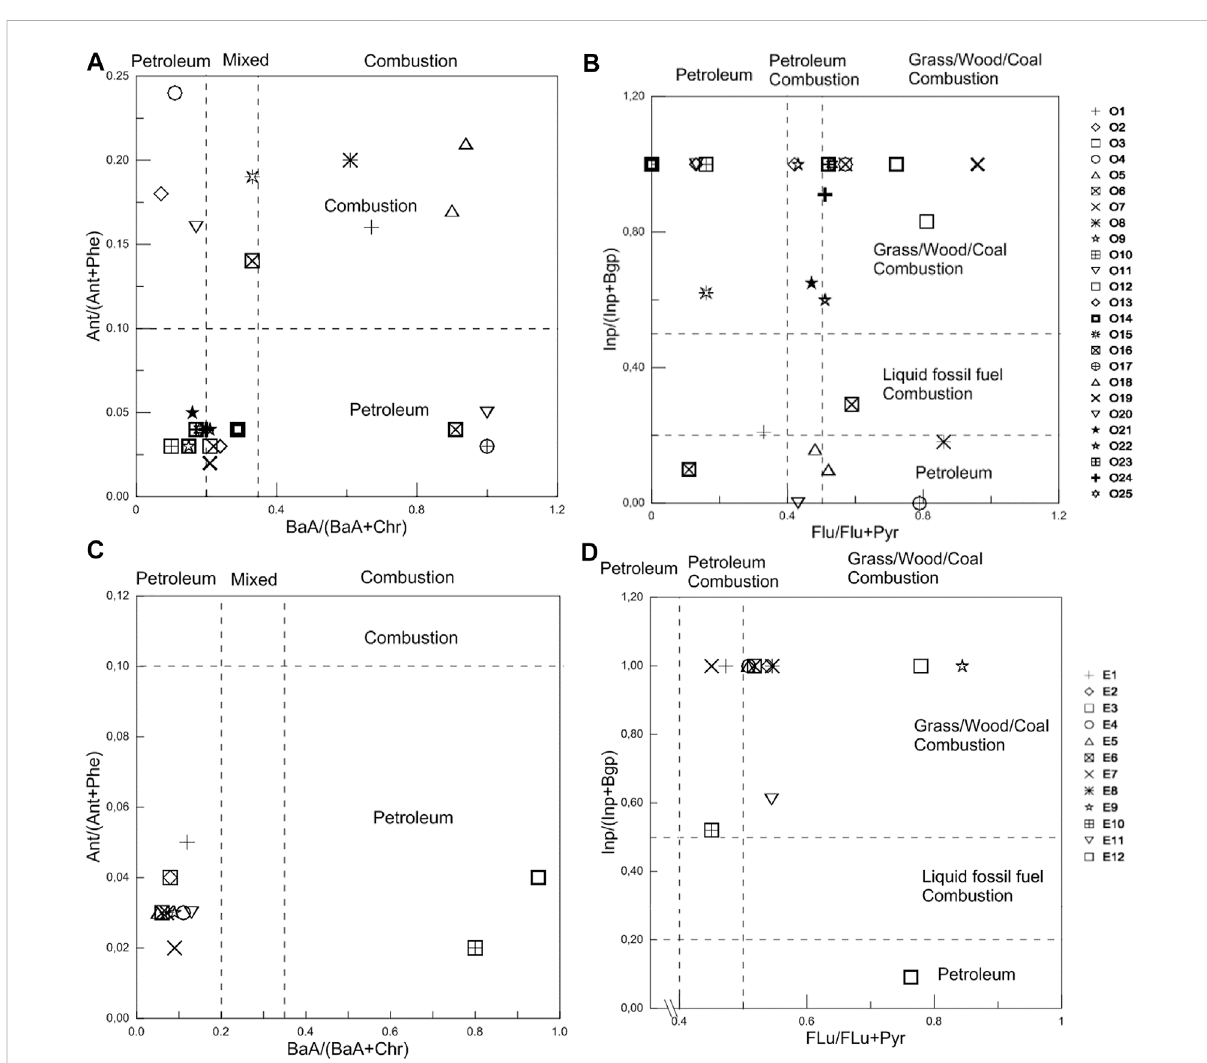
FIGURE 5 PlotsofPAH isomer pair ratiosfor source identi fi cation: (A) Ant/(Ant + Phy) versus BaA/(BaA +Chr) inOilsoil samples, (B) Inp/(Inp + BgP) versus Flu/(Flu+Pyr)inOilsoilsamples, (C) Ant/(Ant+Phy) versus BaA/(BaA+Chr)inEstuarysoilsamples, (D) Inp/(Inp+BgP) versus Flu/(Flu+Pyr)inEstuary soil